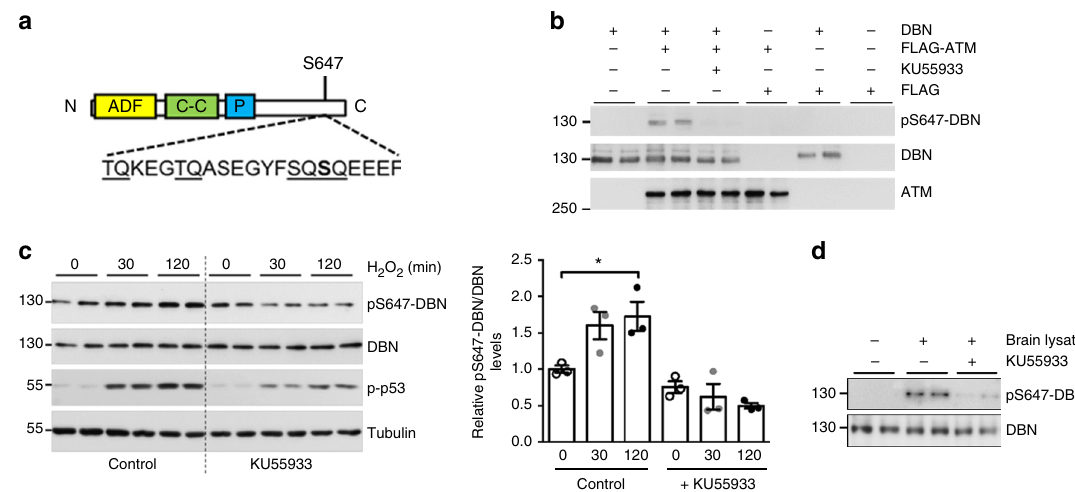
Fig. 4 DBN is phosphorylated by ATM at S647. a DBN domain structure consists of an N-terminal ADF/co fi lin homology domain (ADF), a coiled-coil (C – C) domain and a proline-rich stretch (P). The amino acid sequence surrounding S647 is characterized by several SQ and TQ motifs. b ATM in vitro kinase assay. Puri fi ed FLAG-ATM or FLAG were incubated with recombinant DBN in the absence ( − ) or presence ( + ) of the ATM inhibitor KU55933. Molecular weight protein ladder is in kilodaltons. c HEK 293T cells were exposed to H 2 O 2 (250 µ M) in the presence of DMSO (control) or 10 µ M KU55933. Left: representative western blot analysis of pS647-DBN, DBN and tubulin. Levels of phosphorylation of p53 were used as control for ATM activity. Right: Bar graph shows the relative band density of pS647-DBN/DBN in three biologically independent experiments ± SEM; One-way ANOVA Bonferroni test. * p < 0.05. d In vitro kinase assay using recombinant DBN and adult mouse brain extract in the presence of DMSO ( − ) or KU55933 ( + ). DBN developmentally regulated brain protein, ATM ataxia-telangiectasia mutated, DMSO dimethyl sulphoxide, ANOVA analysis of variance